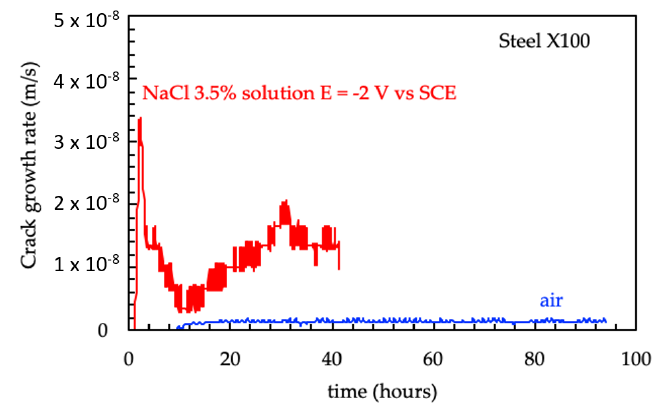
Figure 9. Crack growth rate as a function of time for the API 5L X00 steel in air (blue curve) and in NaCl 3.5% solution at − 2 V vs. SCE (red